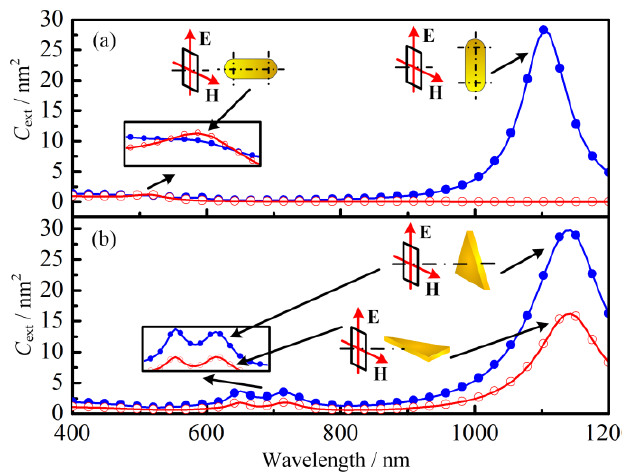
Figure 2. Extinction cross section of ( a ) gold nanotriangles (GNTs) and ( b ) gold nanorods (GNRs) with different incident direction of electromagnetic waves. The results are the average value of extinction cross section when the incident electric field direction is horizontal and vertical. The insets show the partial enlarged views of local maximum. E and H stands for electric and magnetic fields, respectively.